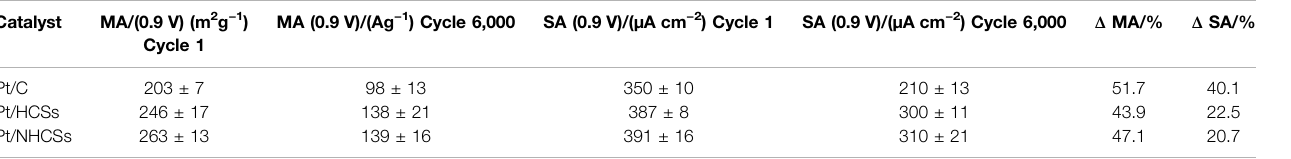
TABLE 2 | Comparison of the activity of the Pt/HCSs, Pt/NHCSs and commercial Pt/C before and after 6,000 durability cycles.